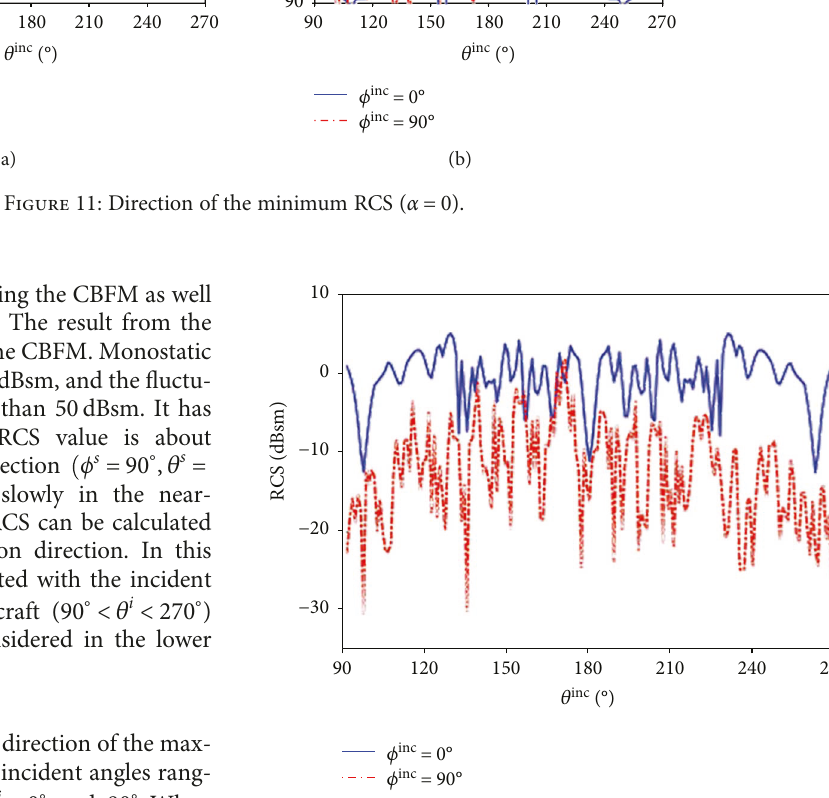
Figure 12: Value of the minimum RCS ( α = 0